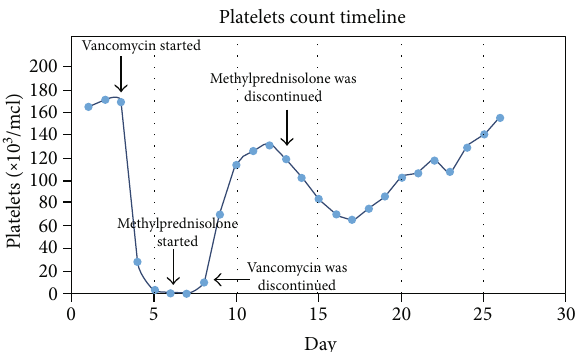
Figure 1: The platelets trend during patient